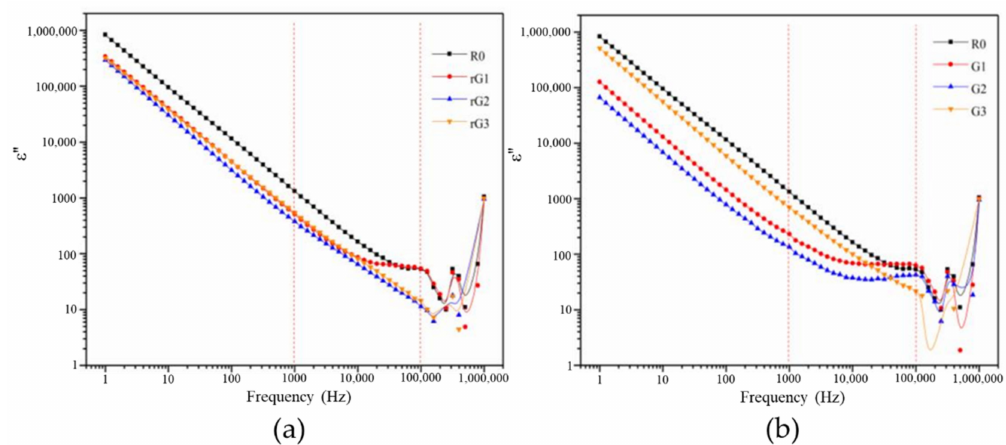
Figure 17. Dielectric loss of the samples with rGO ( a ) and GO ( b )